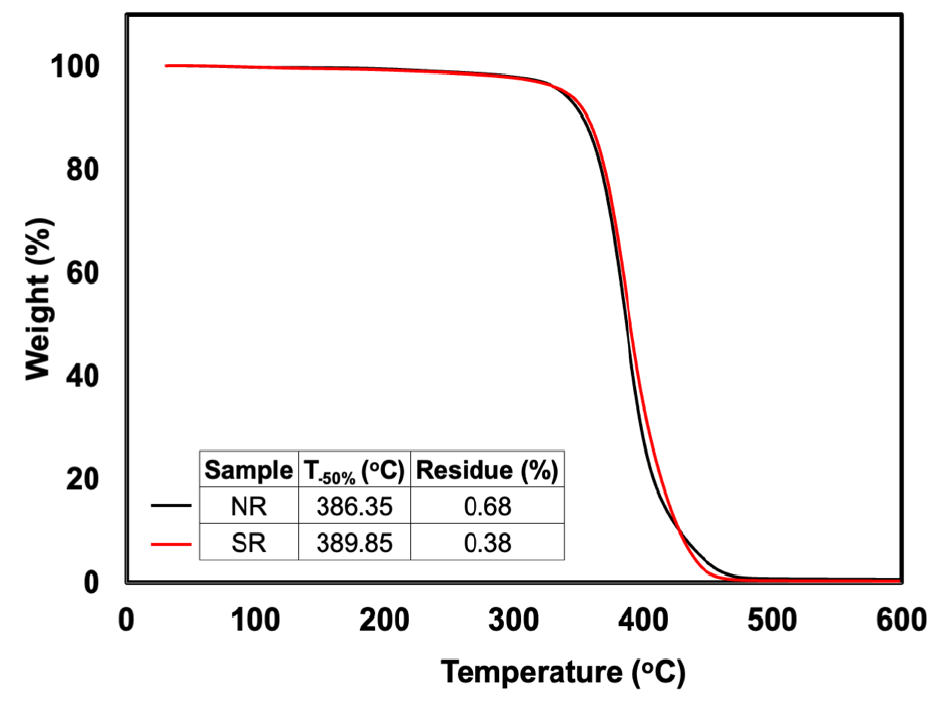
Figure 2. TG curves of NR and